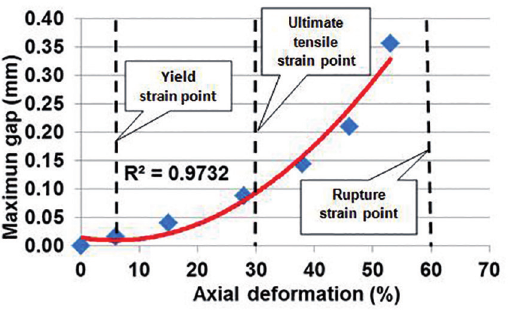
Figure 7: Correlation between maximum gap and axial